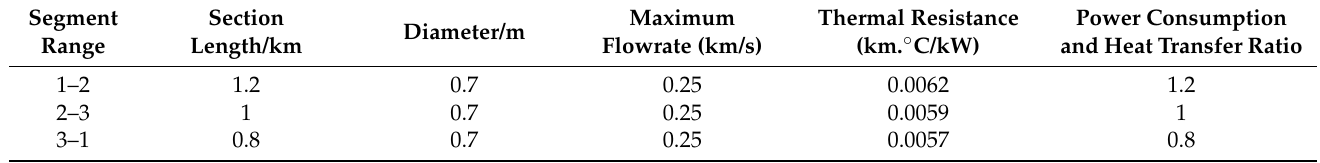
Table 2. Scope of middle pipe section in each park.